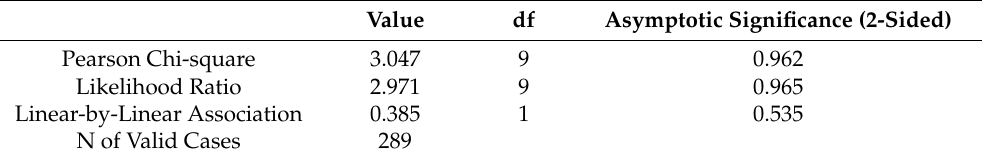
Table 16. Chi-square tests on the correlation between experience in the position/position held and the role of the professional accountant in the digital environment.